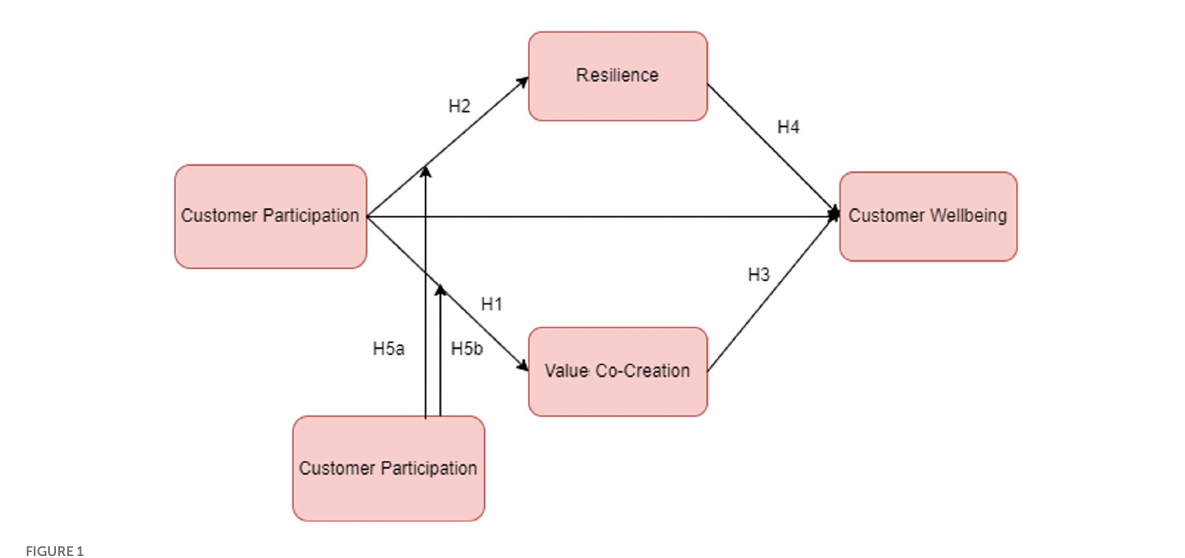
FIGURE 1 Conceptual